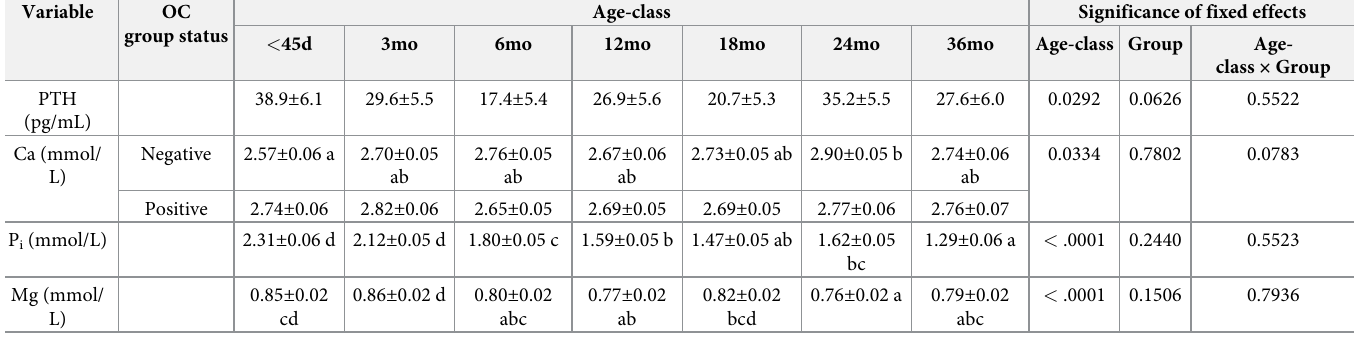
Table 6. Plasmatic concentrations of parathyroid hormone, calcium, phosphorus and magnesium of Lusitano horses (n = 24 � ) from birth to 36 months of age according to the radiographic status.